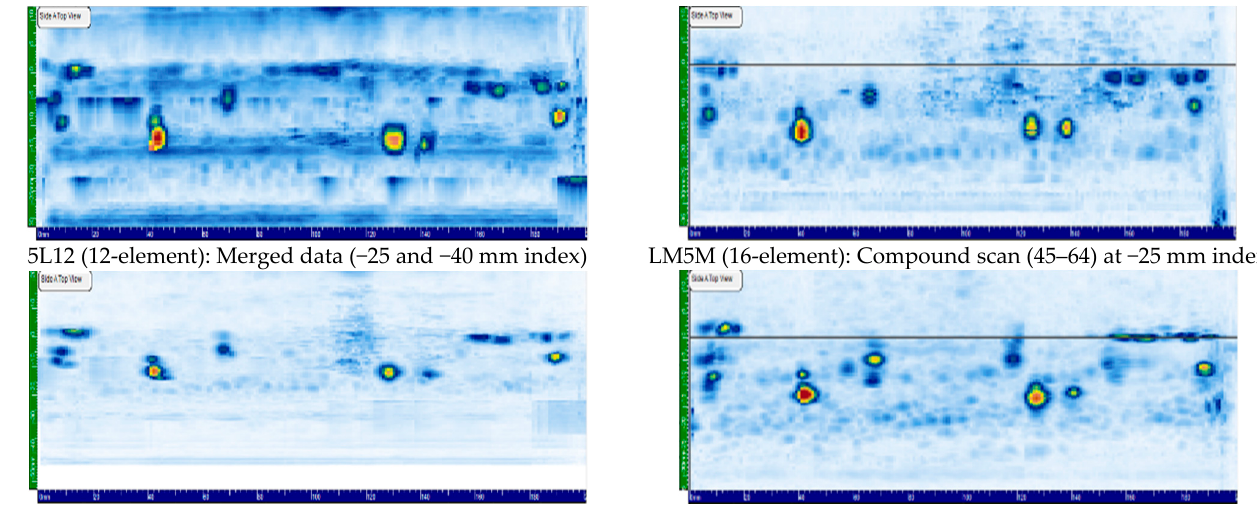
Figure 4 . Example of PAUT results (Side A, Side view). Figure 4. Example of PAUT results (Side A, Side